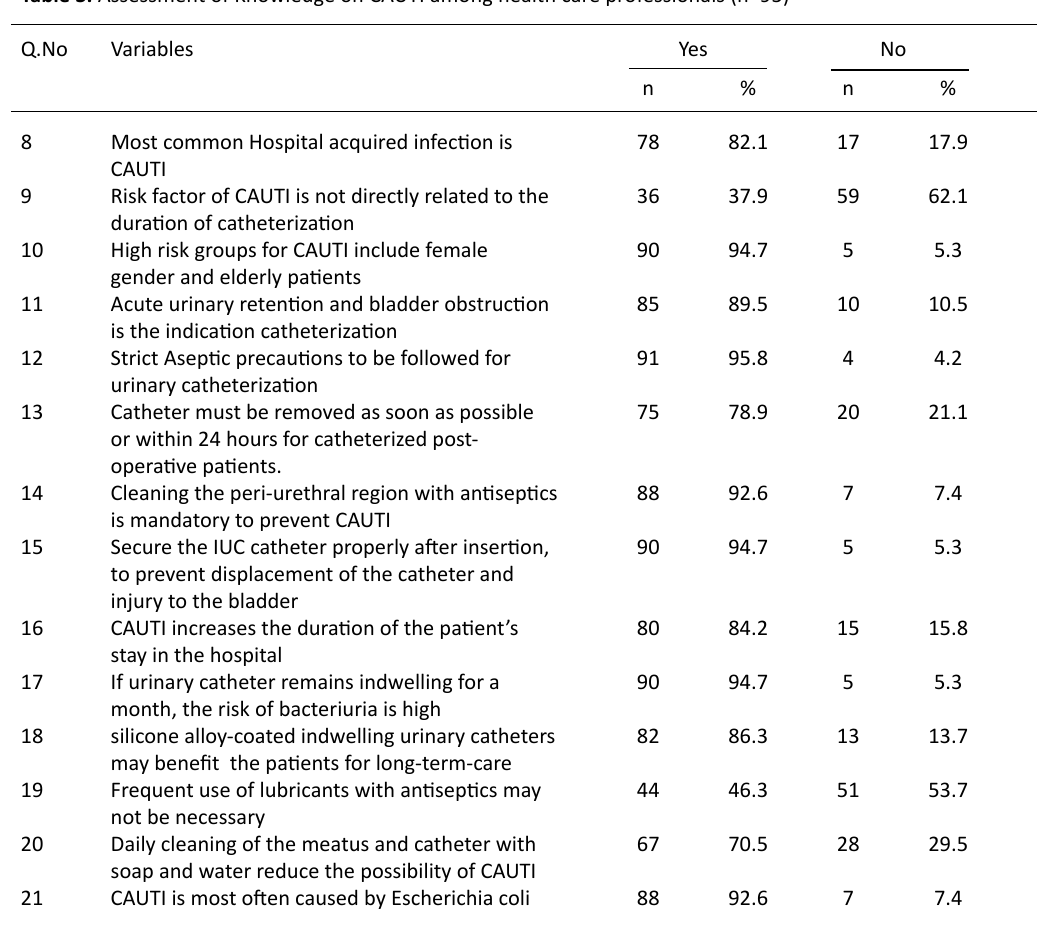
Table 3. Assessment of Knowledge on CAUTI among health care professionals (n=95) Q.No